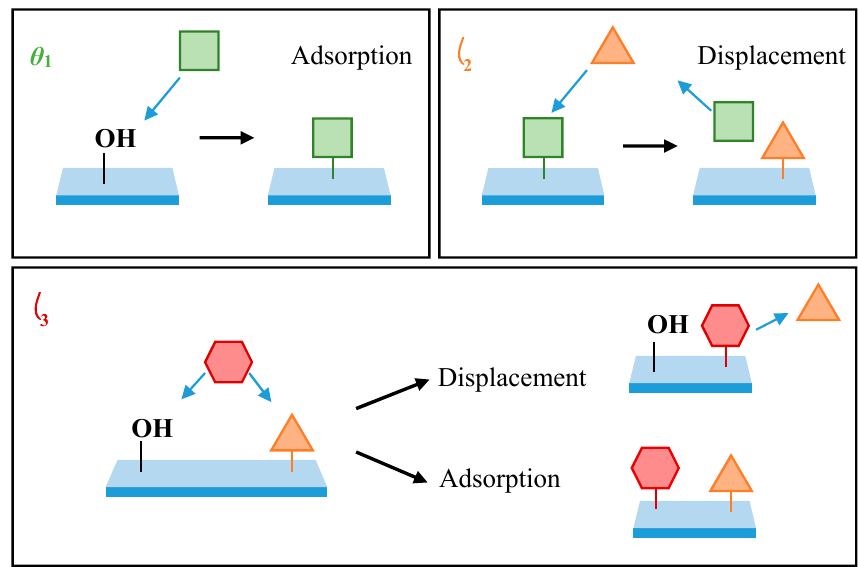
Figure 1. The 3-component model used to describe the oscillatory nature of silane adsorption on metal oxide substrates, adapted from Quinton et al. [11,12]. Silicon containing species θ 1 and θ 3 are represented by squares and hexagons, while the non-silicon containing species θ 2 (H 2 O) is represented by a triangle.